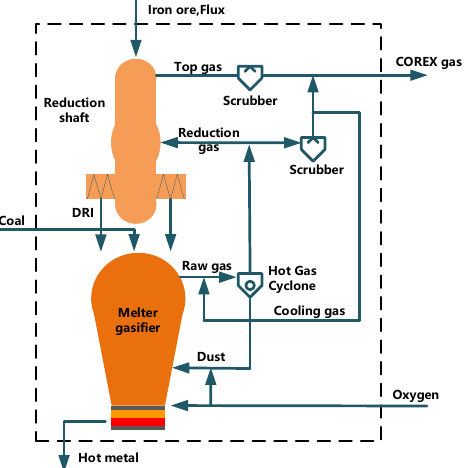
Figure 2. The flow diagram of the COREX ® ironmaking process.